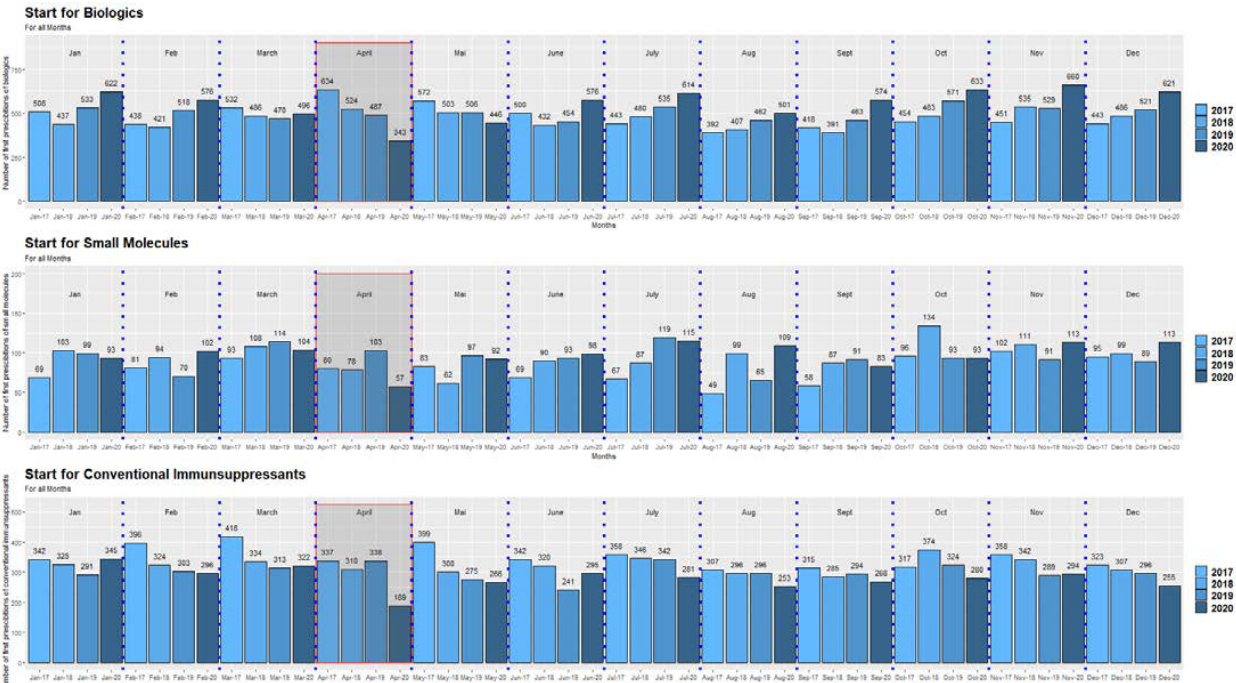
Figure 1. Starts of biological medications, small molecules, and conventional immunosuppressive medications in the period 2017–2020. The red rectangles mark the timeframe of a significant decrease of the initiation of biologics, small molecules as well as conventional immunosuppressants during the first lockdown (April 2020 compared to the corresponding timeframe of previous years). The scaling of the y -axis differs for the presentation of the three medication groups to demonstrate at best the decrease of the medication starts in April 2020.